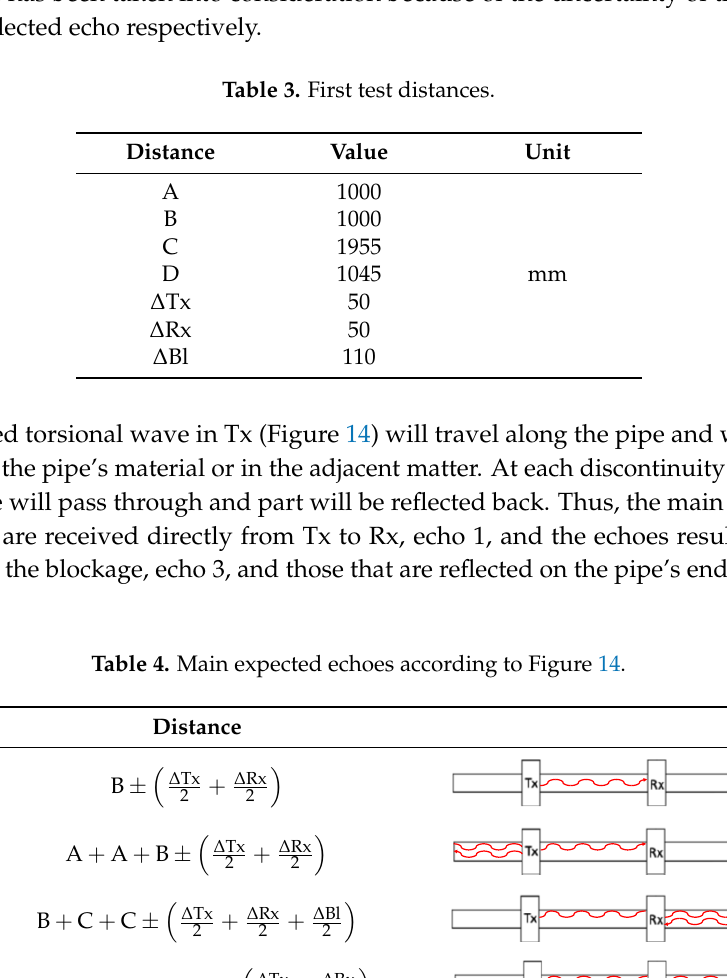
Figure 14. Test arrangement.